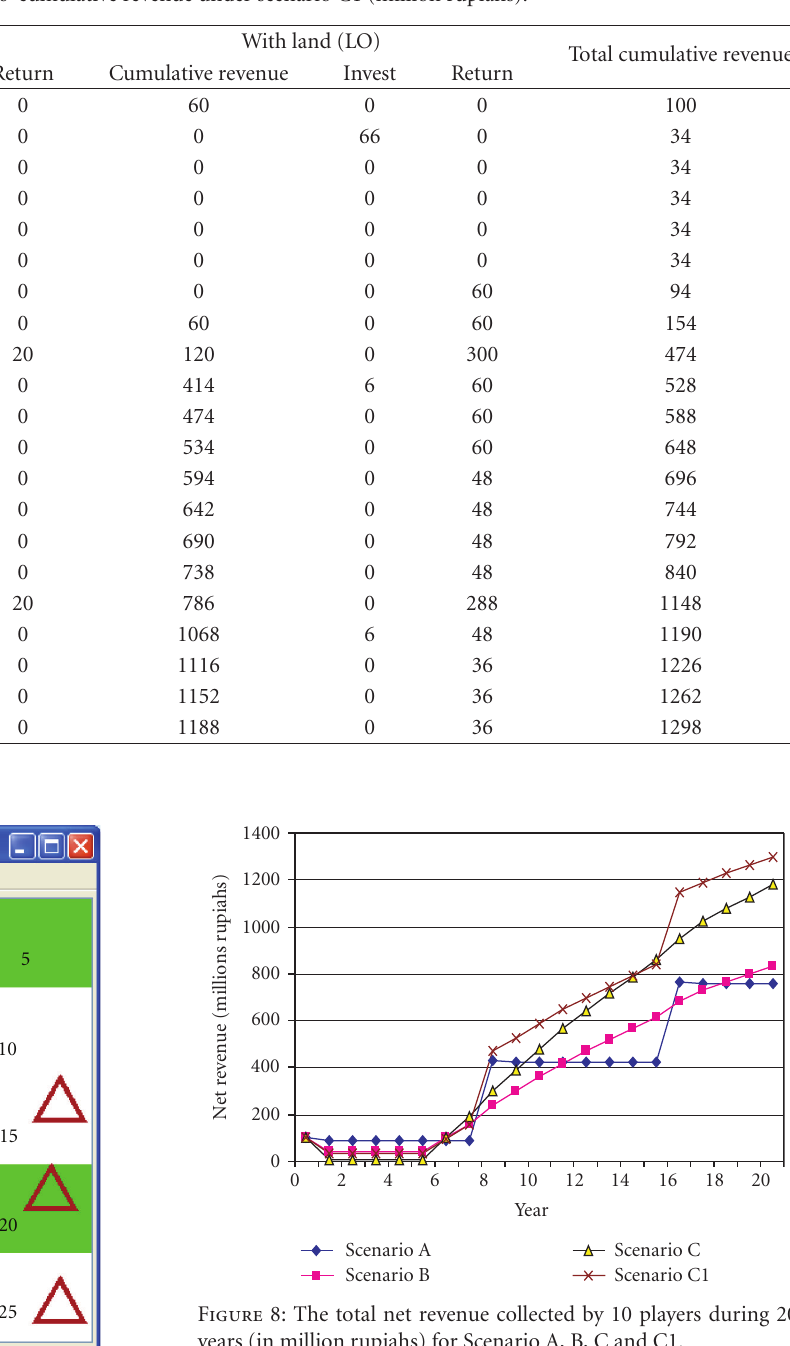
Table 5: The players’ cumulative revenue under scenario C1 (million rupiahs).